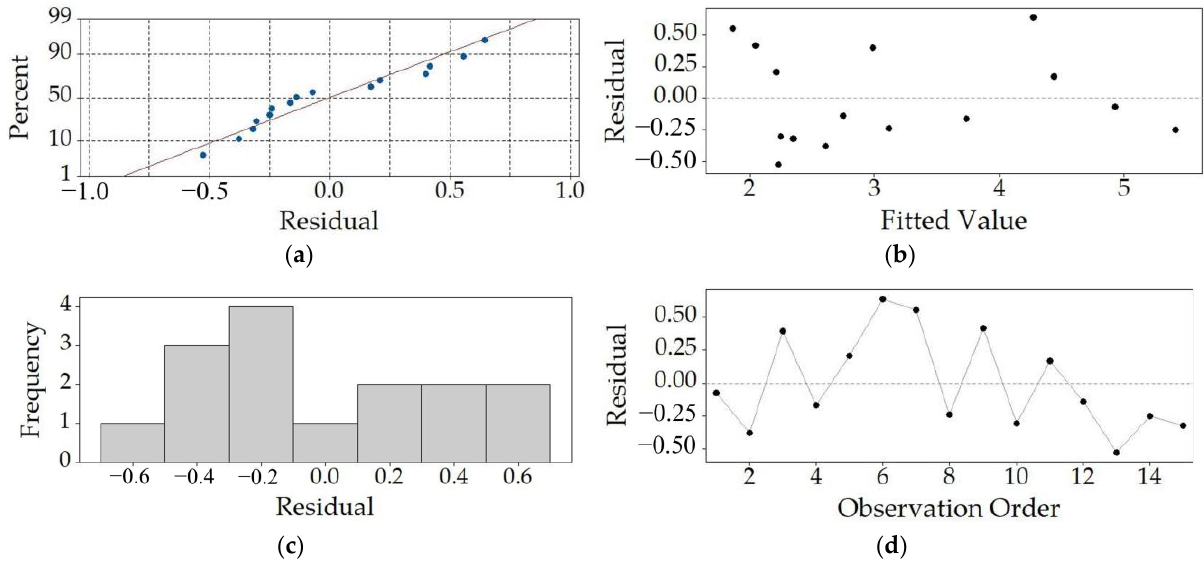
Figure 7. Residual analyses for P p-p_max : normal probability plot ( a ), residuals vs. the fitted value plot ( b ), frequency vs. residuals graph ( c ) and dependence of the residuals on the observation order ( d ).